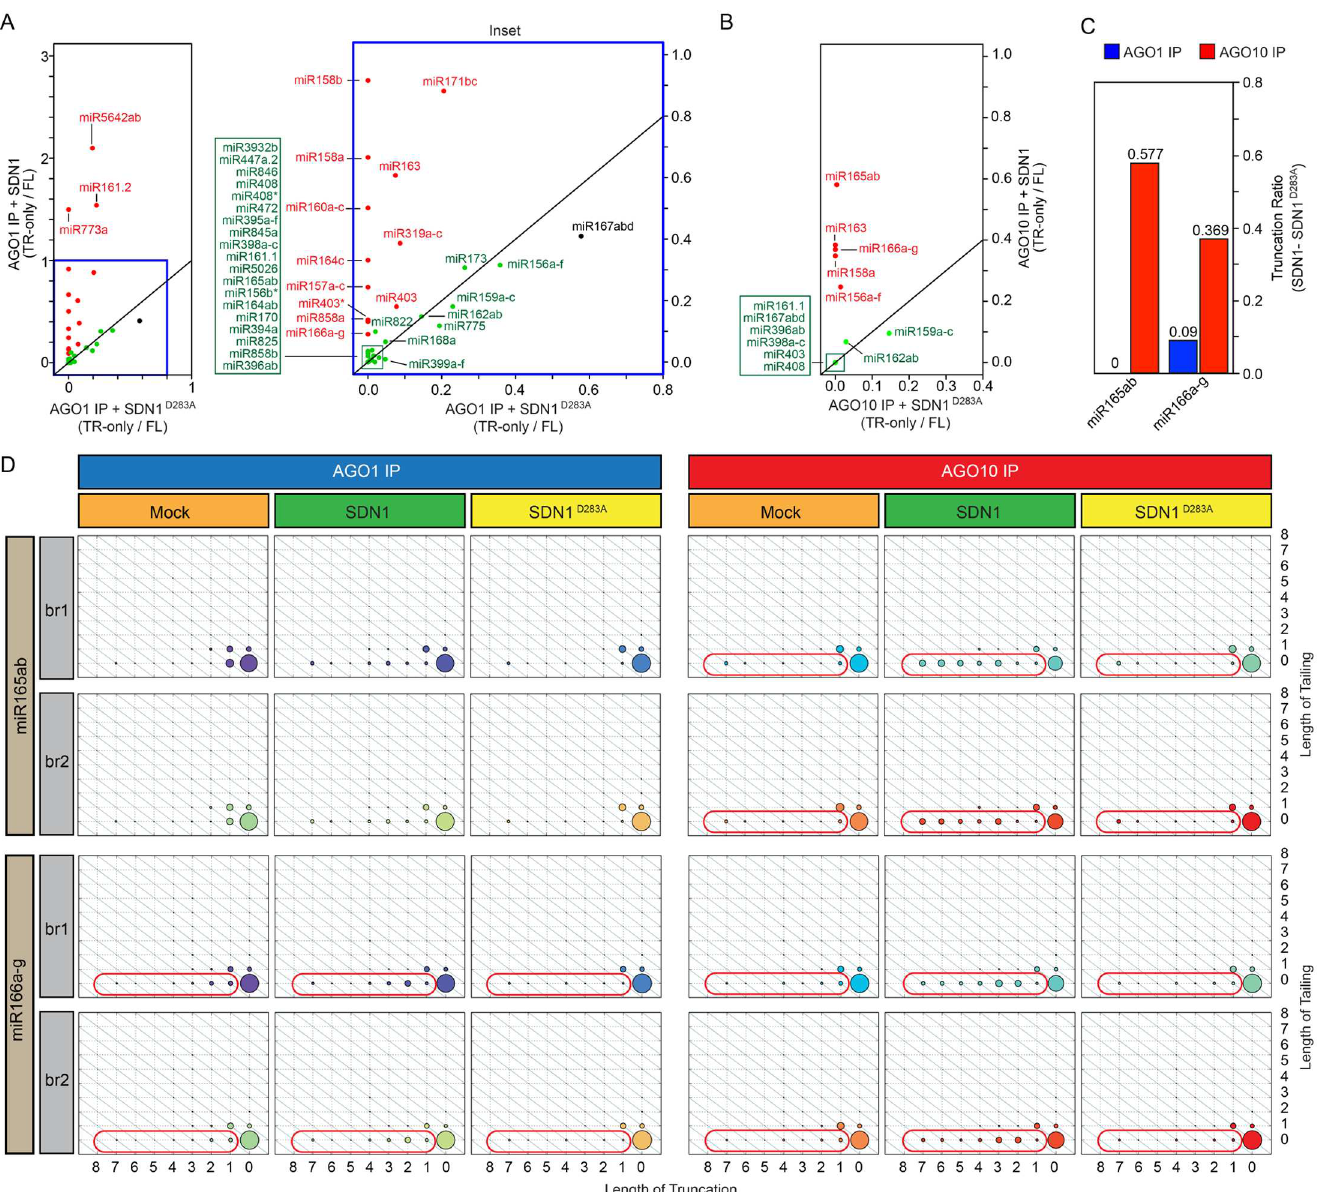
Fig 2. SDN1 is able to trim AGO1- and AGO10-bound miRNAs in vitro. AGO1 IP or AGO10 IP was used as the substrate in enzymatic reactions with mock (no enzyme), SDN1, or a catalytic mutant (SDN1 D283A ) in two biological replicates.sRNA-seq was conductedto examinethe 3 0 trimming of miRNAs. (A-B) Plots showingthe ratio of 3 0 TR-only species to FL speciesfor various miRNAs after the enzymatic reactions. TR-only species present in the mock control were subtracted from the SDN1 or SDN1 D283A reactions. The diagonallines represent equal levels of 3 0 truncatedspecies in the SDN1 and SDN1 D283A reactions, indicating that the truncatedspecies were not generatedby SDN1. The miRNAs marked in red showed SDN1-mediated 3 0 truncation. As the levels of 3 0 truncation were low, the two biologicalreplicateswere combinedto derive the values. Only abundantmiRNAs (RPM > 10) were examined.(C) Bar plot showinghigherlevels of 3 0 truncation by SDN1 of miR165/6in AGO10 IP than in AGO1 IP. The y -axis represents SDN1-mediated3 0 truncation; any truncated speciespresent in the SDN1 D283A reactions were subtracted from those in the SDN1 reactions. (D) Diagrams showingthe status of 3 0 truncation and tailing of miR165/6. The x -axis representsthe number of nucleotides truncatedfrom the 3 0 end. The y -axis represents the numberof nucleotidesadded to the 3 0 end. The relativeproportions of the speciesare indicatedby the sizes of the circles. Two biological replicates (br1 and br2) are shown separately. The 3 0 truncatedspecies accumulating at higherlevels in the SDN1 reactions relativeto the mock and SDN1 D283A reactions are marked. Underlying data can be found in the GEO databaseas series GSE87355. The raw data for panels (A-C) can be found in S1